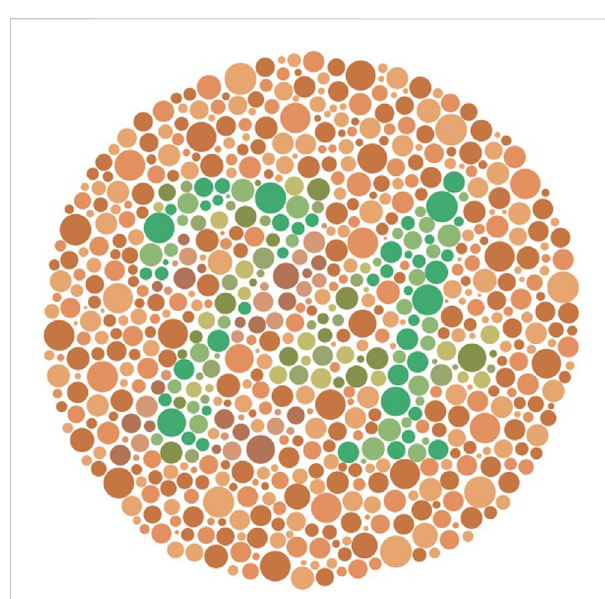
FIGURE 4 For participants with normal color vision, “ 74 ” should be clearly visible, “ 21 ” should be clearly visible for participants with red-green color blindness, and participants with monochromacy may see no numbers in the image Bonewit-West et al.